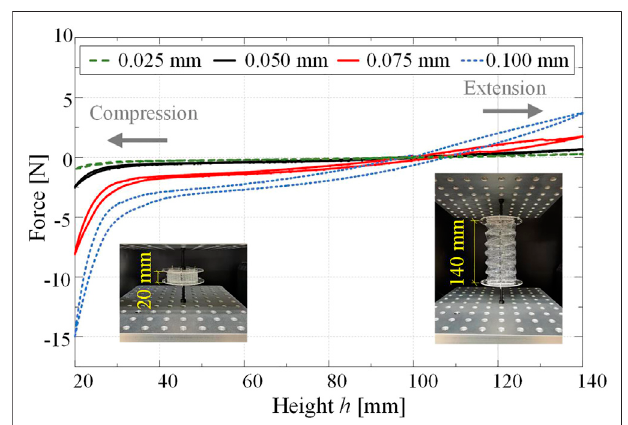
FIGURE 7 | Experiments on the mechanical properties of a six-layer Yoshimura-oristructureprototypeintheaxialdirection.Theconstitutiveforce- displacement curves are obtained via quasi-static axial compression and extension tests. The insets show two con fi gurations of the prototype with h (cid:1) 20mmand h (cid:1)